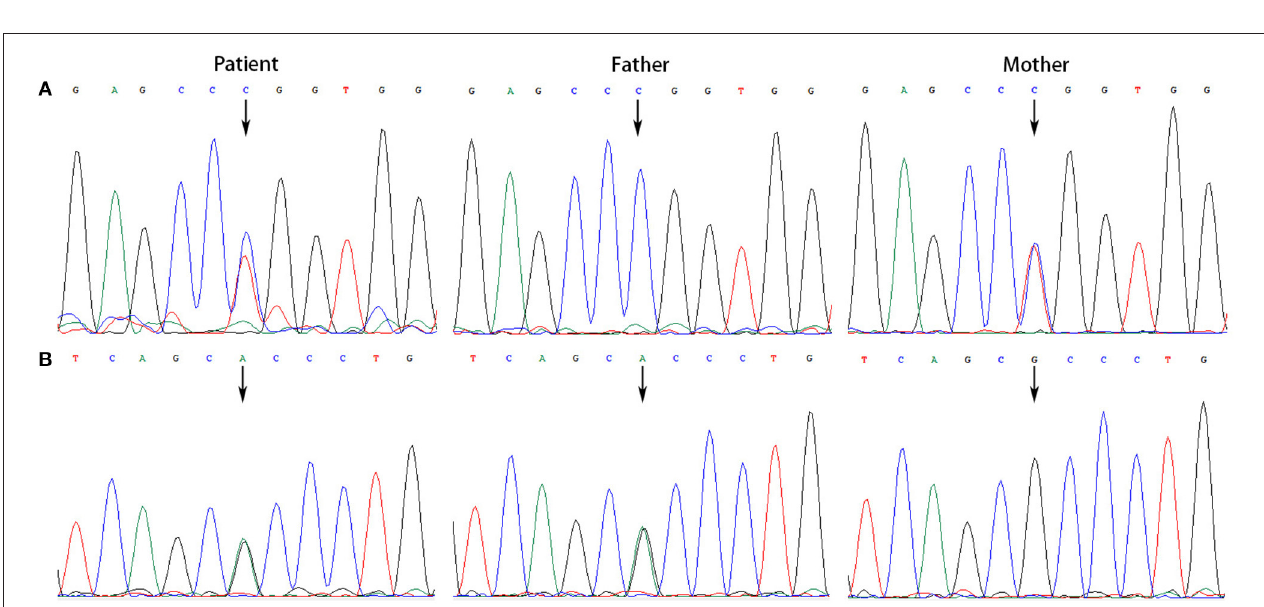
FIGURE 2 | Sanger sequencing of the genomic DNA from patient 1 and her parents. (A) Patient 1 carried with a heterozygous variant of c.689G > A, her father with a normal genotype, and mother with a heterozygous variant of c.689G > A. (B) Patient 1 carried with a heterozygous variant of c.1456G > A, her father with a heterozygous variant of c.1456G > A, and mother with a normal genotype.